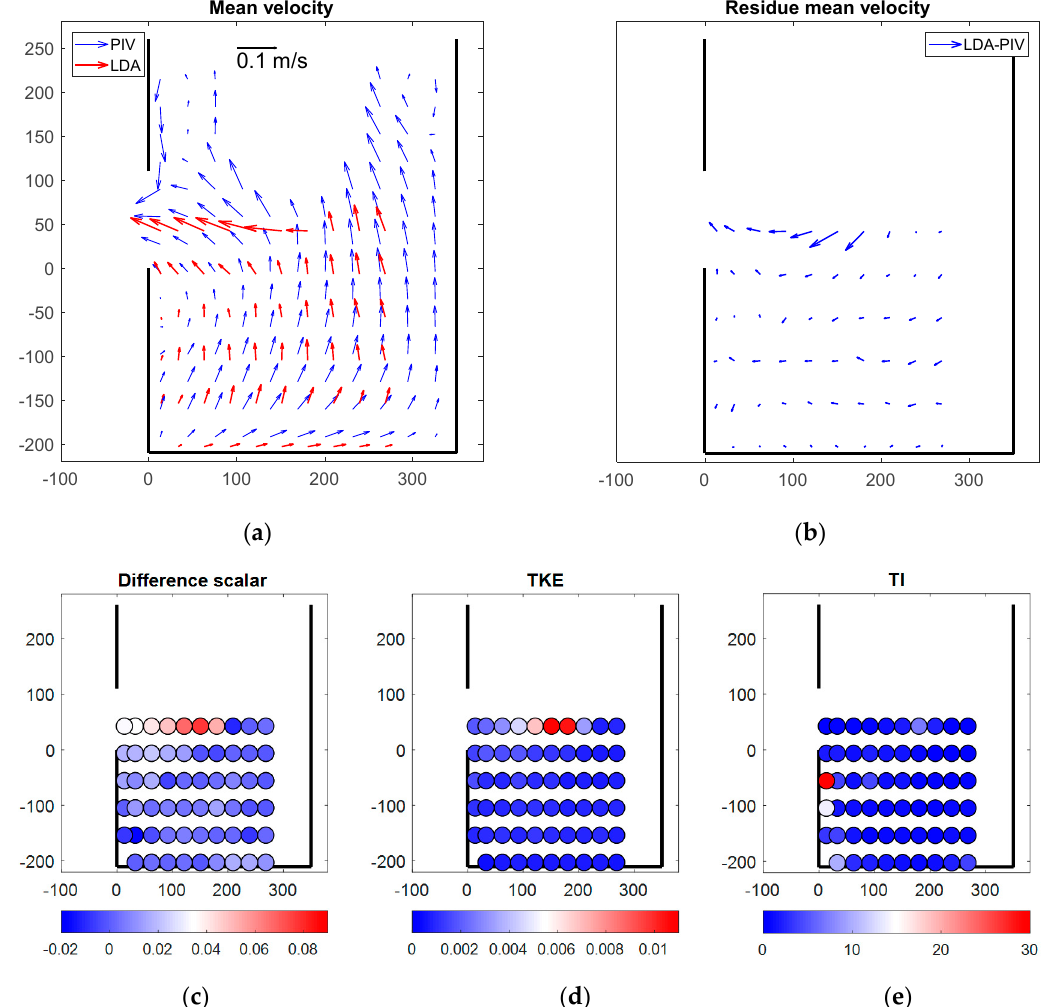
Figure 10. PIV and LDA results for the test with a sand trap depth of 0.21 m, outlet at the back, and discharge 1.0 L/s. ( a , b ) Comparisons of the mean flow velocity; ( c ) The difference scalar as defined by equation 18; ( d , e ) TKE and TI based upon the LDA measurements.